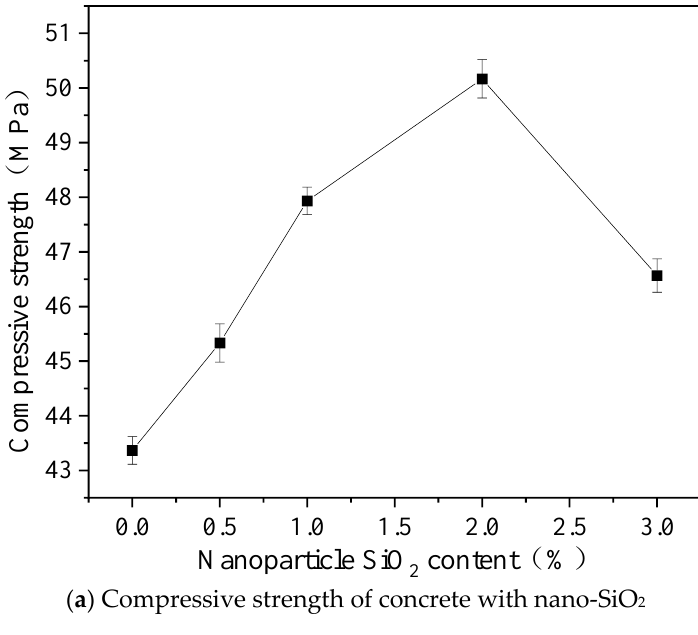
Figure 2. Slump of concrete with nano-SiO 2 .